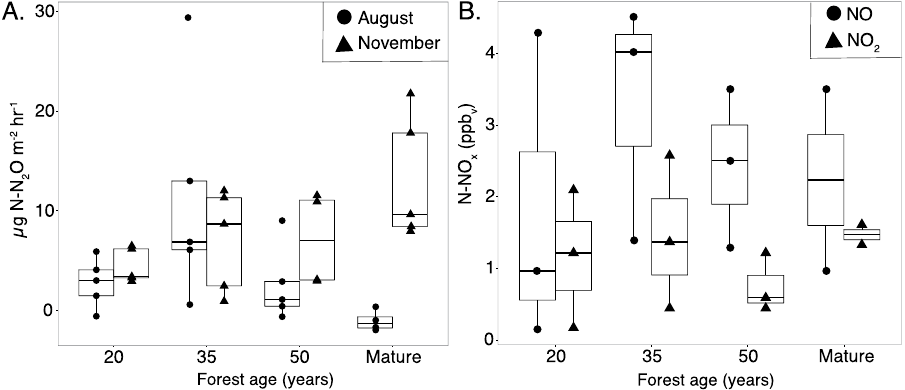
Figure 2. Nitrogen oxide soil emissions along secondary successional forest chronosequence. ( A ) nitrous oxide (N 2 O) emissions. Circles = August sampling and Triangles = November sampling (n = 5), and ( B ) nitrogen oxide emissions. Circles = NO and Triangles = NO 2 . (n = 3, except mature forest n = 2). Data is shown as boxplot with the median value indicated by the band near the middle of the box, the first and third quartiles are the top and bottom of the box, respectively, the maximum and minimum values excluding outliers are the whiskers. The effect of forest age is not significant for nitrogen oxide gases examined (p > 0.05; K-W test).